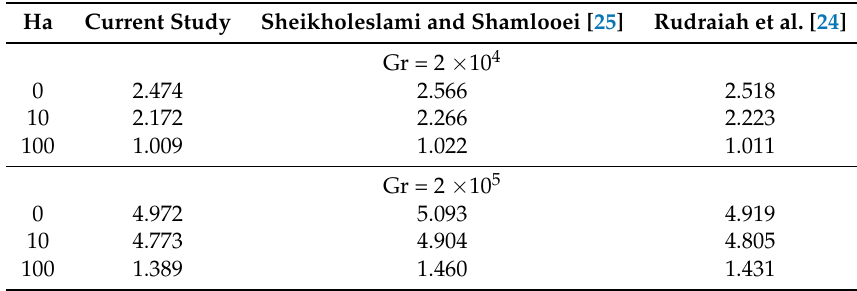
Table 4. Average Nusselt number comparisons for different Hartmann numbers for natural convection in a cavity under the effect of magnetic